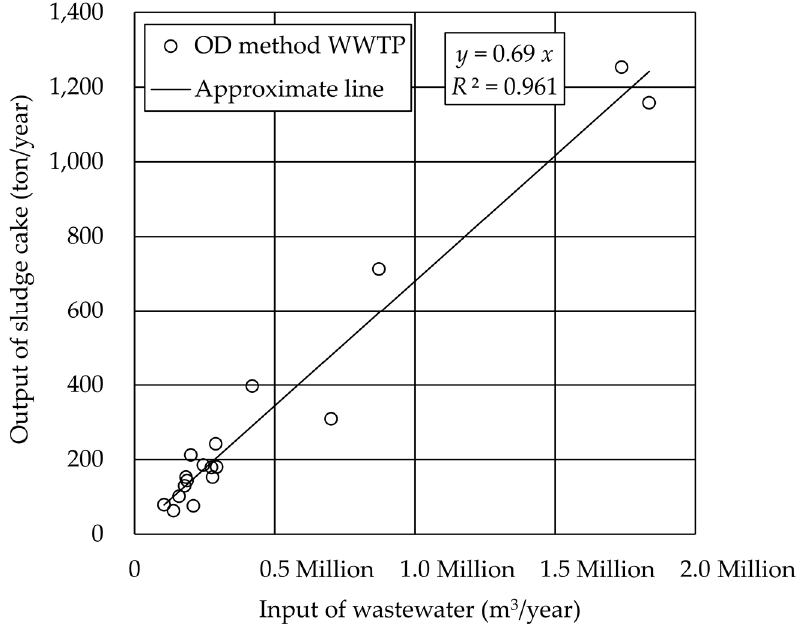
Figure 11. Annual average input of wastewater and related output of sludge cake.